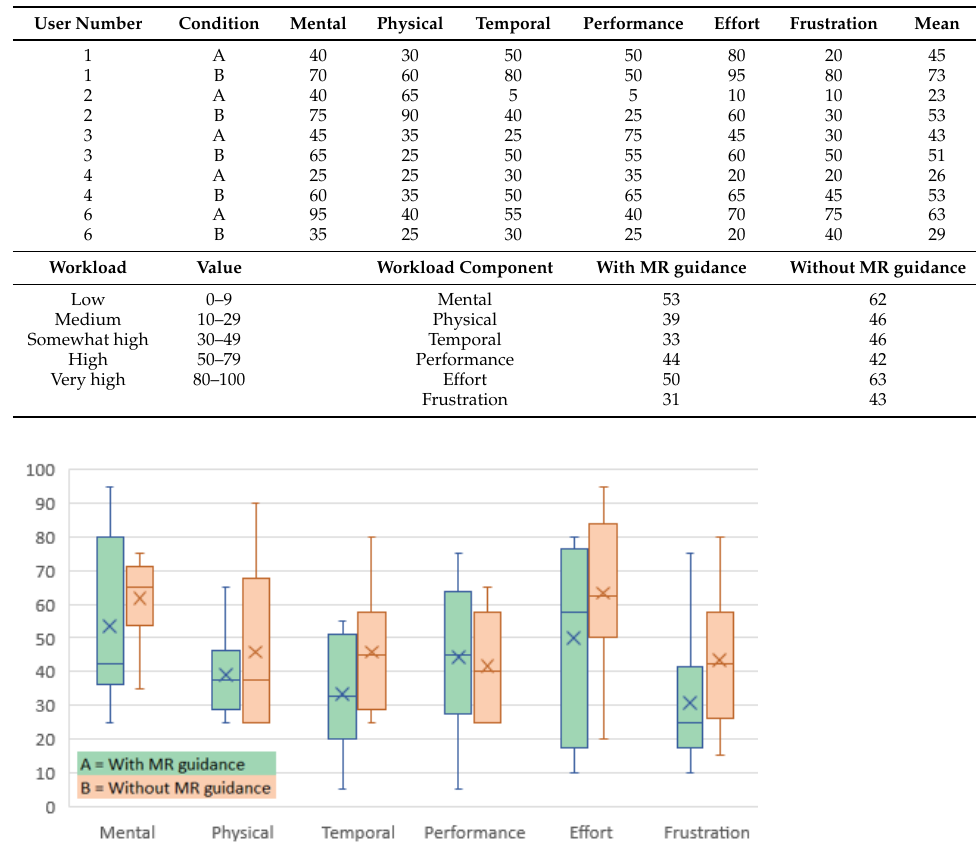
Figure 5. NASA-TLX workload assessment result, represented as a box and whisker chart, grouped into the two experimental conditions A = with MR guidance and B = without MR guidance.